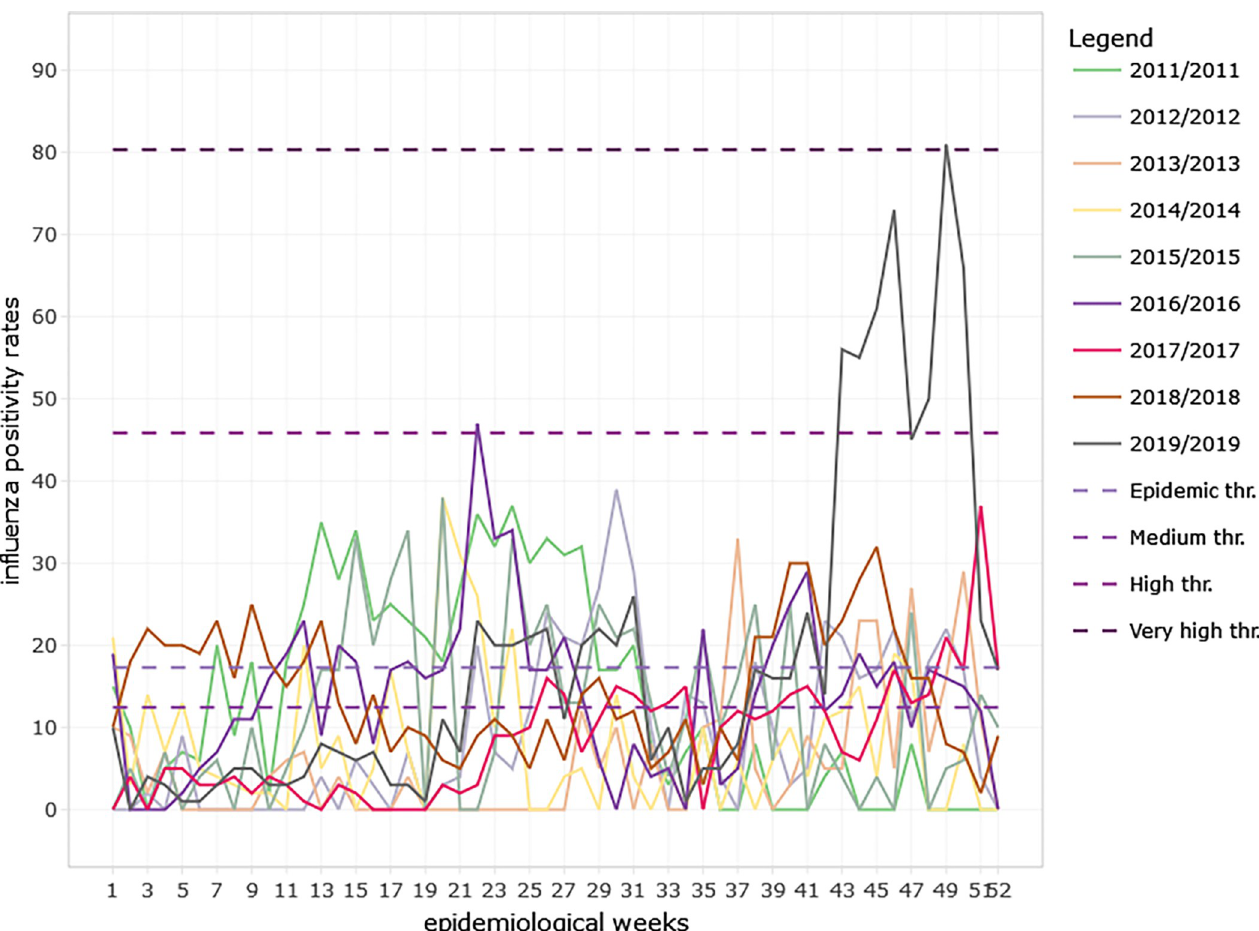
Fig 6. Influenza positivity rates among ILI and SARI cases in Ghana by epidemiological weeks from 2011 to 2019. Intensity thresholds were generated using the MEM web application (R version 4.2.1) and shown with dotted